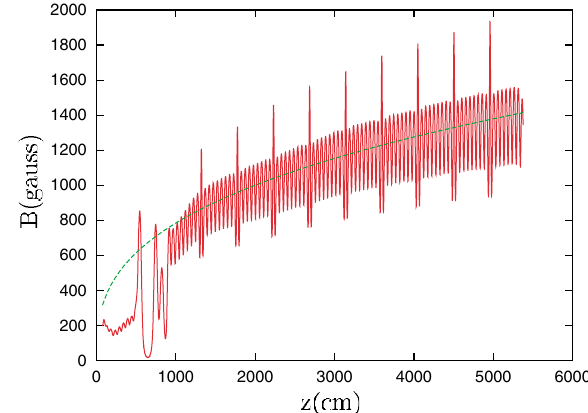
FIG. 7. (Color) Comparison of actual and smoothed axial mag- netic field profile. Simulations start at z (cid:15) 1000 cm .